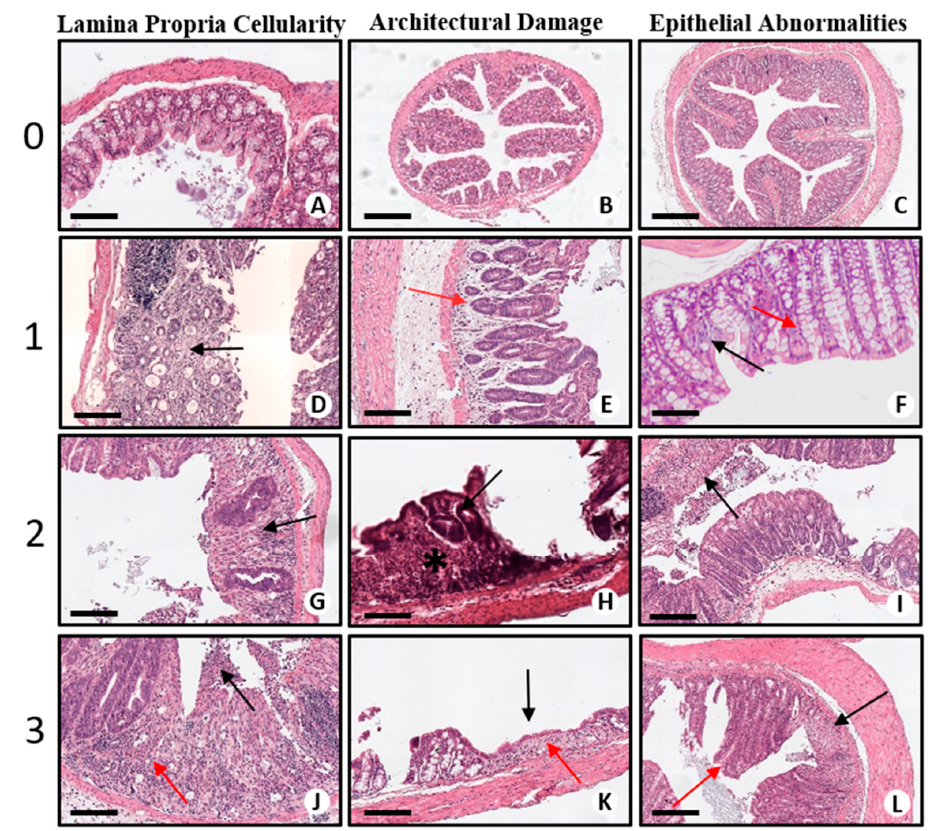
Figure 2. Histological scoring system. ( A ) Normal colonic mucosa with barely visible lamina propria and rare inflammatory cells (lymphocytes and occasional plasma cells). Scale bar represents 200µm. ( B ) Normal colonic mucosa with linear crypts and regular glandular arrangement. Note that there is not any space between bottom of colonic crypts and muscularis mucosae. Scale bar represents 500 µm. ( C ) Normal colonic mucosa without any sign of epithelial damage: glands show regular profile, and their mucinous compartment is preserved. Scale bar represents 500µm. ( D ) Colonic mucosa with mild increase in chronic inflammatory infiltrate (black arrow), mainly characterized by lymphocytes and plasma cells. Scale bar represents 200 µm. ( E ) Colonic mucosa with mild glandular distortion: to note the irregular glandular profile and characteristic doubled bottom (red arrow. Scale bar represents 200 µm. ( F ) Colonic mucosa with reactive epithelial alterations: mucin depletion (black arrow) and repairing/reactive changes with glandular hyperplasia and nuclear hyperchromasia (red arrow). Scale bar represents 200 µm. ( G ) Colonic mucosa with striking increased lamina propria cellularity: dense inflammatory infiltrate (black arrow) characterizes this part of colonic mucosa, along with glandular rarefaction. Scale bar represents 200 µm. ( H ) Evident glandular profile distortion (arrow) with glandular rarefaction and crypt shortening (asterisk), involving <50% of mucosal thickness. Scale bar represents 200µm. ( I ) Colonic mucosa with superficial epithelial erosions (arrow) with superficial fibrin exudate and reactive epithelial changes. Scale bar represents 200 µm. ( J ) Striking presence of acute and chronic inflammatory infiltrate (red arrow); there is neutrophilic infiltration mixed with fibrin and necrotic debris right above ulcerated mucosa (arrow). Scale bar represents 200µm. ( K ) Total epithelial atrophy: there is absence of glands and mucosal flattening (arrow), glands in lamina propria are replaced by collagen and scant inflammatory cells (red arrow). Scale bar represents 200 µm. ( L ) Colonic mucosa with ulcers (epithelial necrosis involving the total thickness of the mucosa (arrow): note the abrupt total loss of glands replaced by granulation tissue and inflammatory infiltrate; the remaining mucosa shows polypoid reactive–regenerative changes (red arrow). Scale bar represents 200 µm.